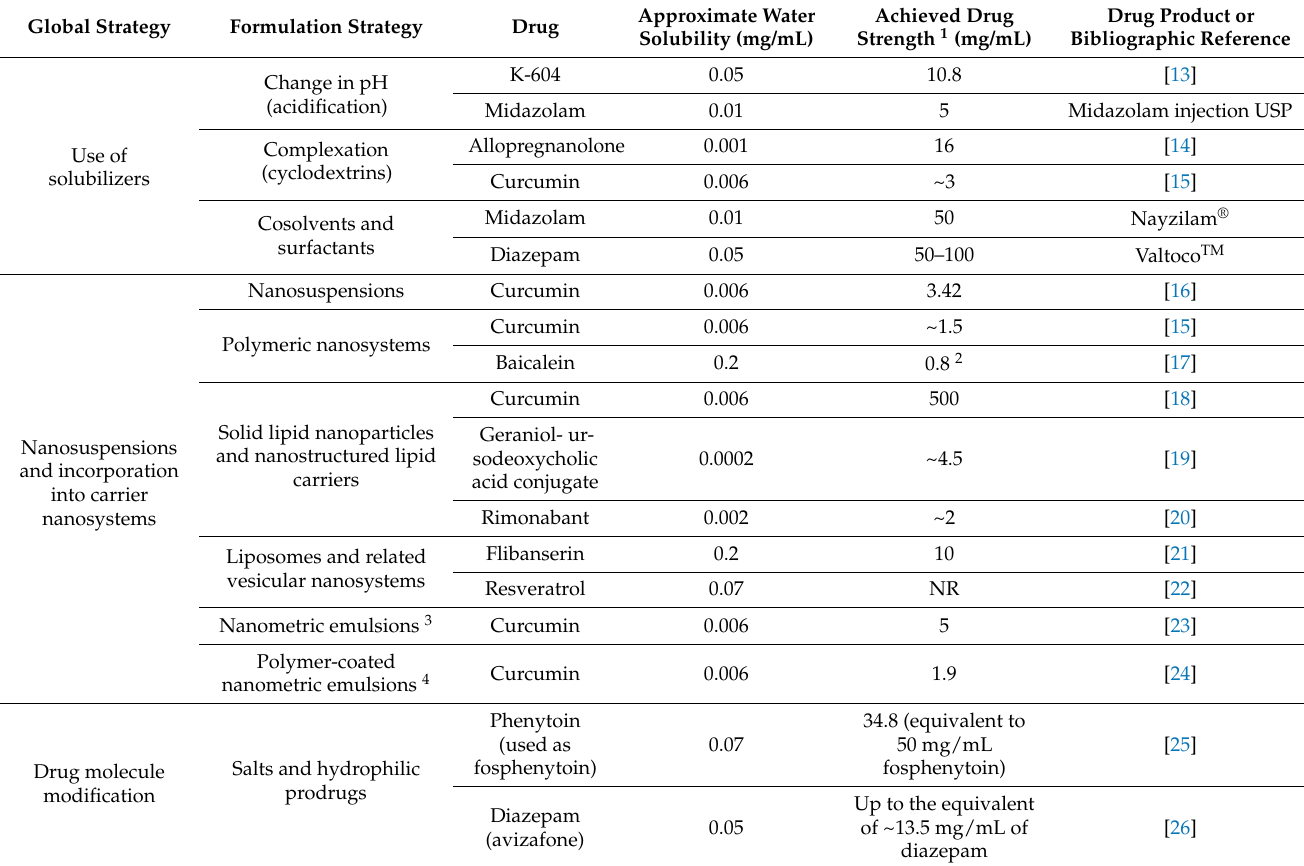
Table 1. Formulation strategies for increasing drug strength of low water solubility drugs in liquid nasal